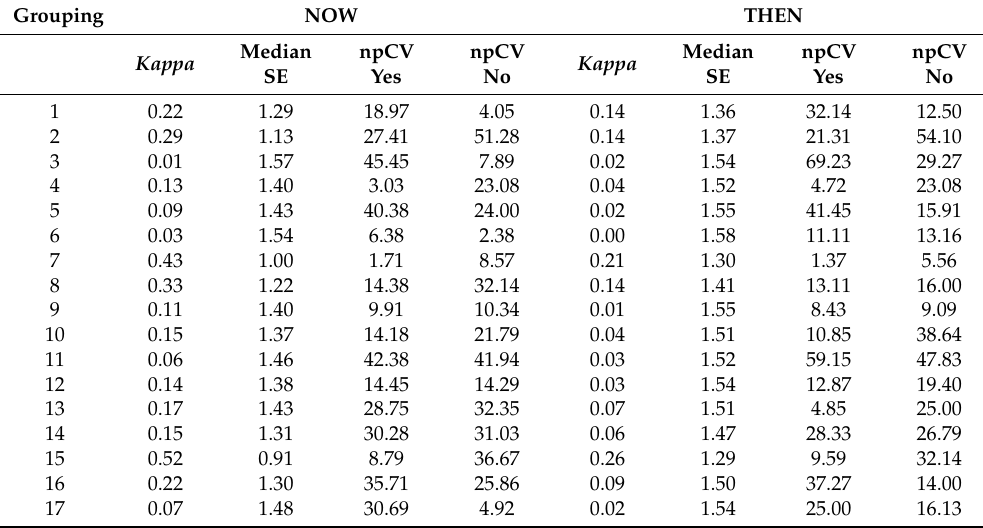
Table A19. Values of kappa , median SE and npCV for the 17 groupings.